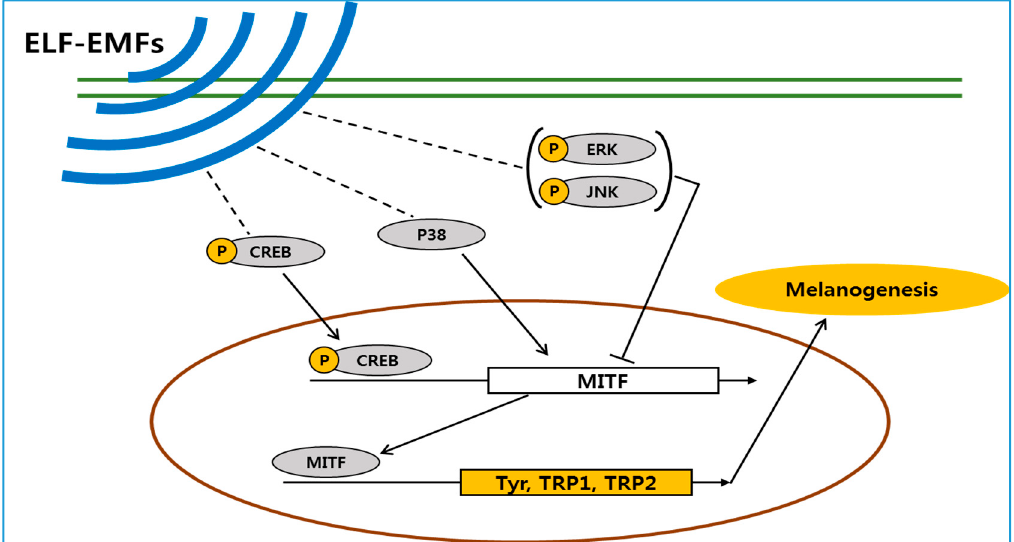
Figure 10. The proposed mechanism by which an extremely low frequency electromagnetic field (ELF-EMF) induces melanin biosynthesis. Schematic shows that ELF-EMFs increases expression of microphthalmia-associated transcription factor (MITF) in human melanocytes. (p-CREB: phosphorylated cAMP response element-binding protein, p38: protein 38kDa, p-JNK: phosphorylated c-Jun N-terminal kinase, p-ERK: phosphorylated extracellular signal-regulated protein kinase, MITF microphthalmia-associated transcription factor, Tyr: tyrosinase, TRP: tyrosinase-related protein)